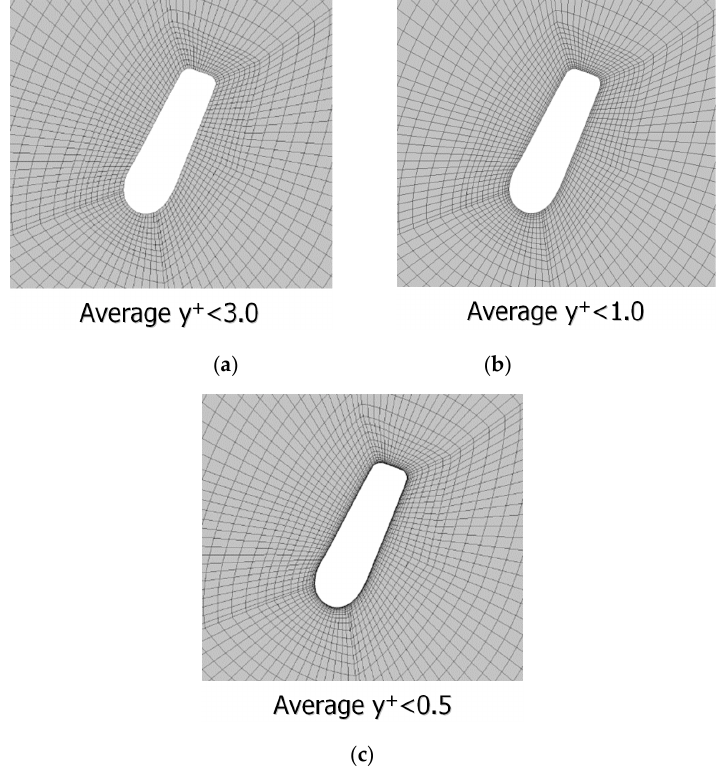
Figure 8. Comparison of grid resolution near blade tip. ( a ) Coarse grid; ( b ) standard (medium) grid; ( c ) fine grid. Table 1. Simulation conditions for the 1/88 scale wind turbine model. RANS: Reynolds-averaged Navier–Stokes.